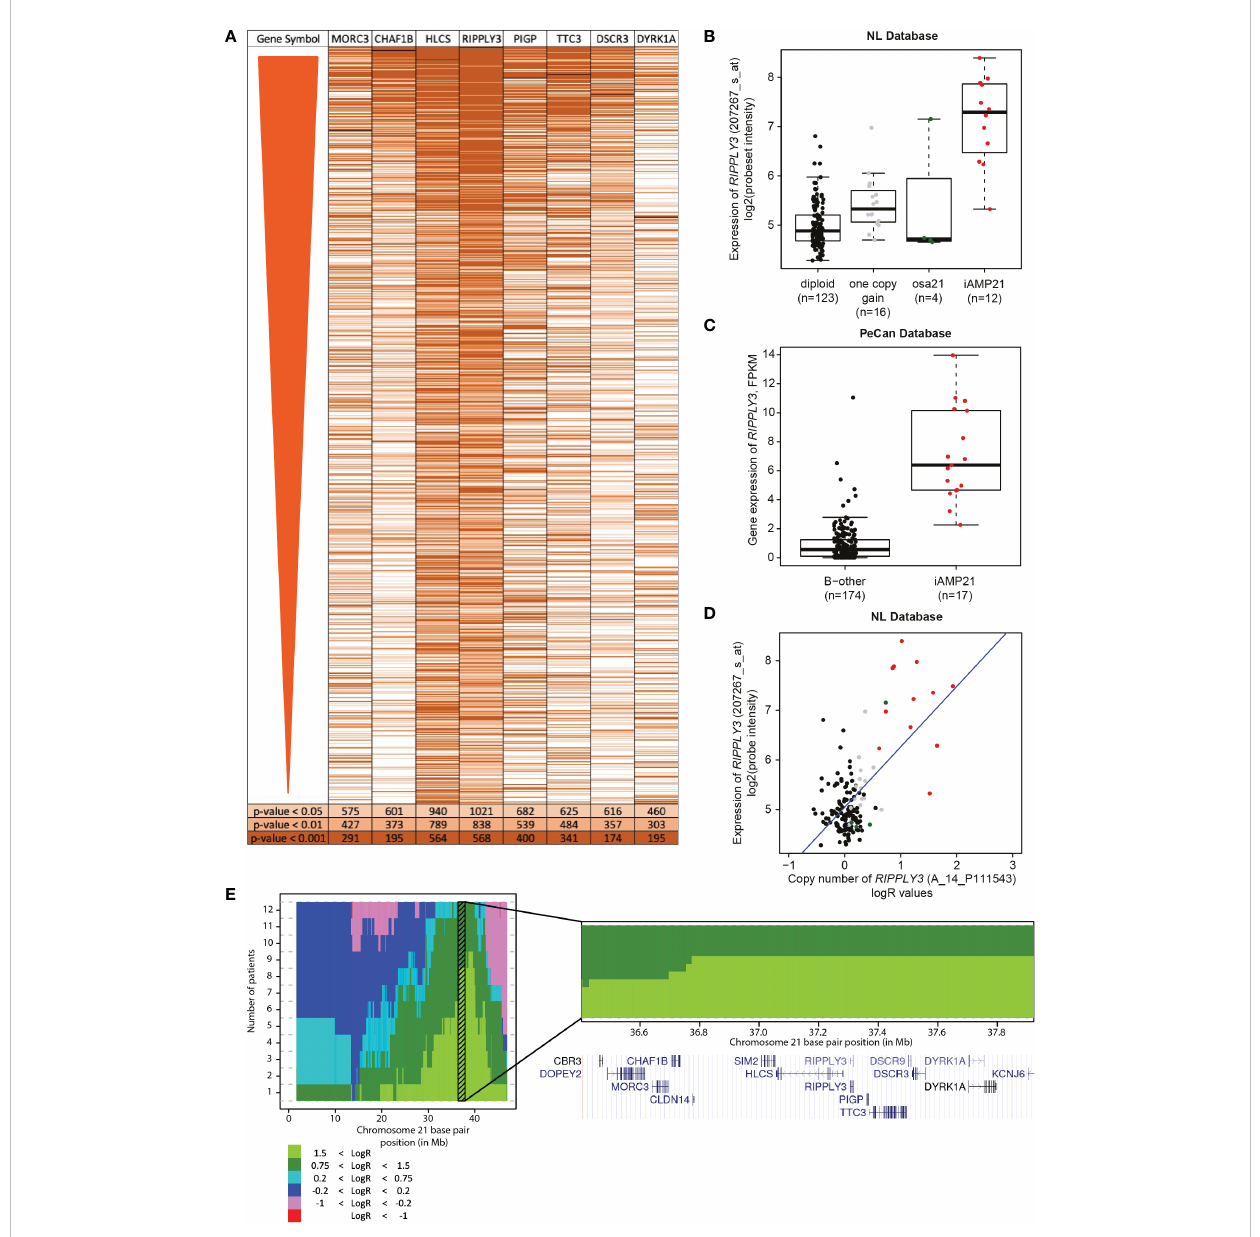
FIGURE 4 Correlation of RIPPLY3 (also known as DSCR6 ) and the iAMP21 signature. (A) Heatmap showing the signi fi cant probesets in the differential gene expression analysis (FDR < 0.01; limma), ordered on FDR from lowest to high. Each row represents a probeset, colours show correlation of the probeset to one of the eight selected probesets, determined with gene-set testing (Globaltest). Light orange: local globaltest FDR < 0.05; medium orange: FDR < 0.01; dark orange: FDR < 0.001. (B) Expression levels of RIPPLY3 (log2 intensities) categorized based on chromosome 21 copy number aberrations determined by aCGH: diploid, one copy gain, other structural aberration on chromosome 21 (osa21), and iAMP21. (C) Expression of RIPPLY3 (FPKM) in the PeCan database. Selected cases are categorized based on iAMP21 status, as described in the PeCan database. (D) Correlation between copy number (normalized LogR values, x-axis) and gene expression (log2 values, y-axis). Cases are coloured based on chromosome 21 copy number aberrations determined by aCGH: diploid, one copy gain, other structural aberration on chromosome 21 (osa21), and iAMP21. Blue line represents the linear regression trendline using all samples shown in this fi gure. (E) Histogram showing the cumulative copy number in all 12 iAMP21 cases. Chromosome 21 base pair position is shown on the x-axis (reference genome hg18), number of cases on the y-axis. Colours show the segmented LogR values, see legend. Shaded region shows the combined CRA. Bottom panel shows a zoom-in of the combined CRA. Gene locations are indicated by the UCSC genome browser cut-out. DSCR3 is also known as VPS26C